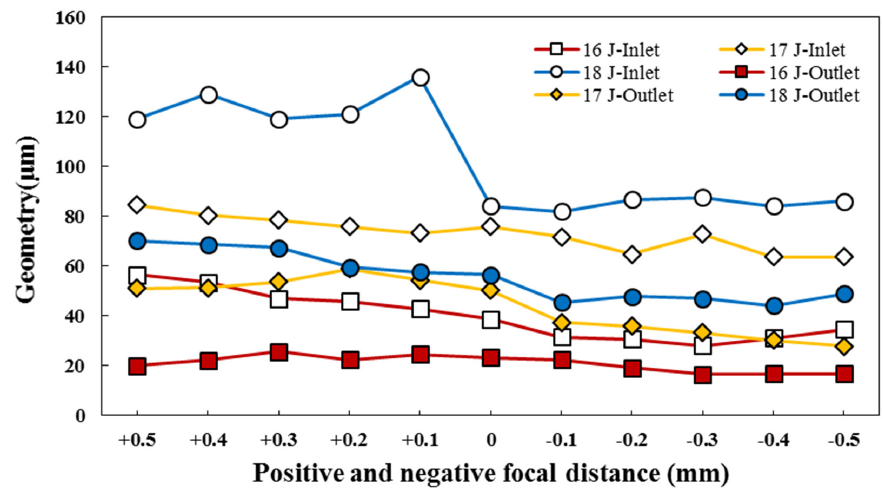
Figure 15. Relationship between positive and negative defocusing distance and diameter.